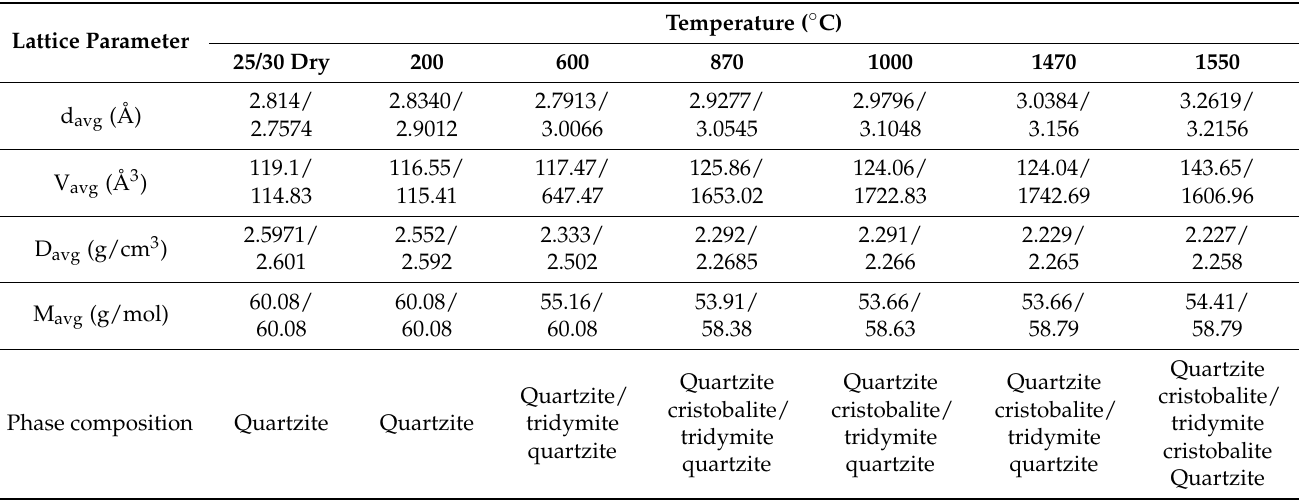
Table 3. Average parameters and phase composition of the quartzite crystal lattice.